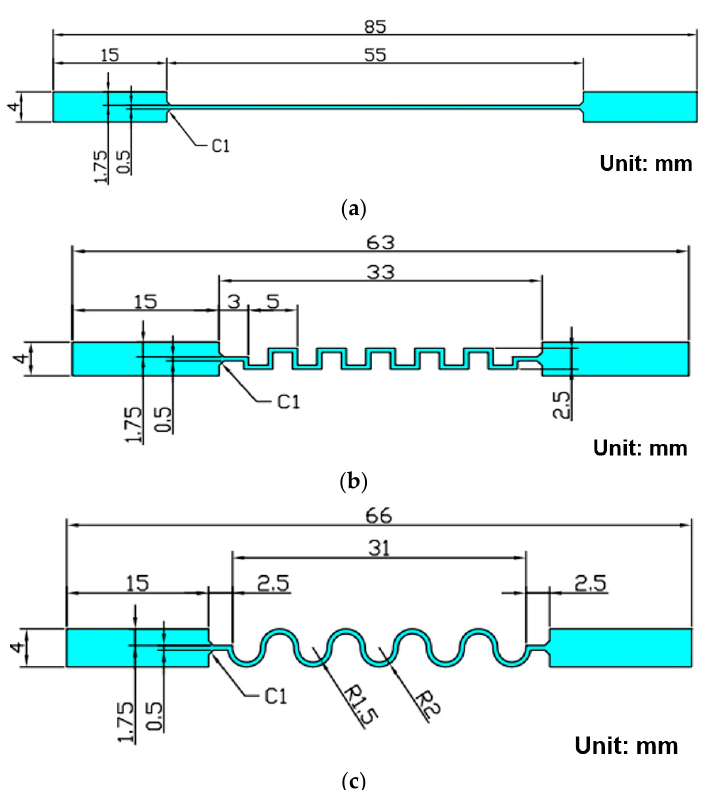
Figure 10. Types of test specimens for the validation of stretchable function: ( a ) straight line; ( b ) transition line; ( c ) horseshoe line (sine wave sharp).